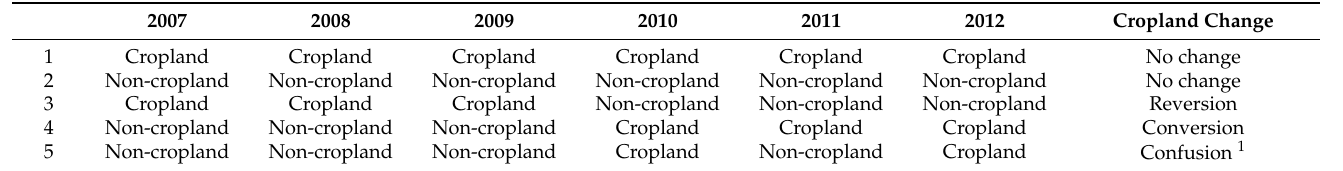
Table 2. Examples of cropland change